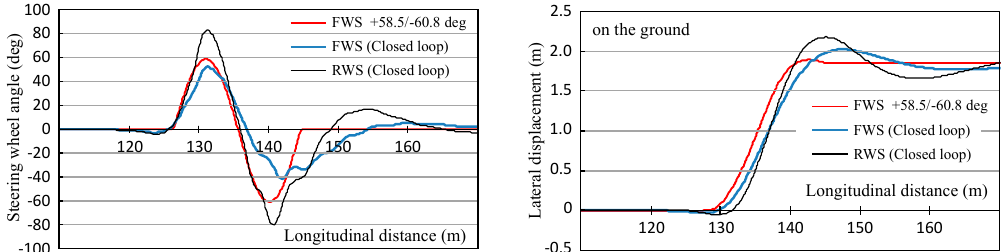
Figure 21. Steering wheel angle and lateral displacement.